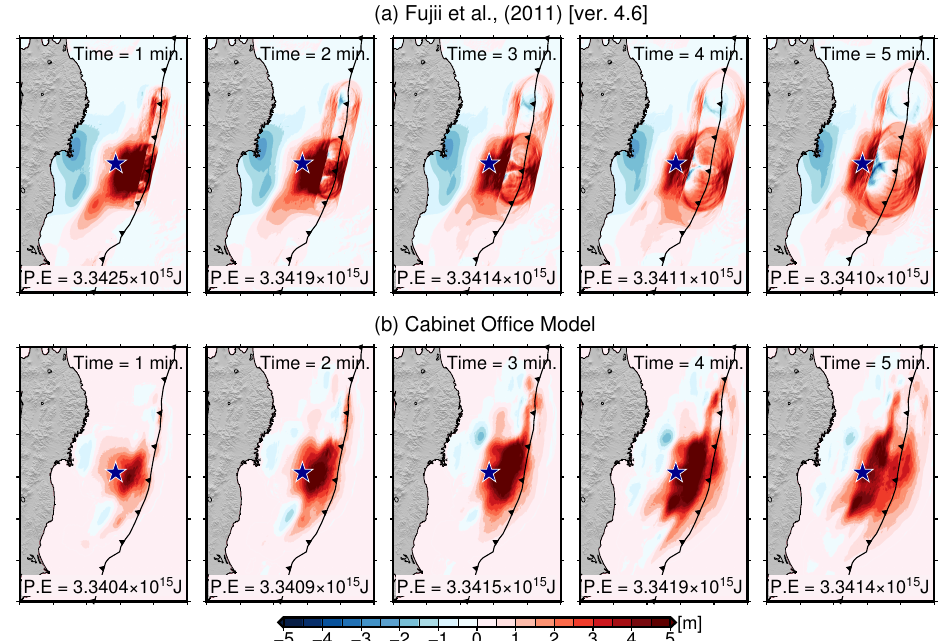
Figure 3. Snapshots at 1, 2, 3, 4, and 5 min of tsunami propagation. ( a ) Snapshots calculated from the tsunami source model proposed by Fujii et al. [1]; ( b ) Snapshots calculated using the spatio-temporal earthquake slip distribution proposed by the Cabinet Office of Japan [9]. The blue star indicates the location of the epicentre.